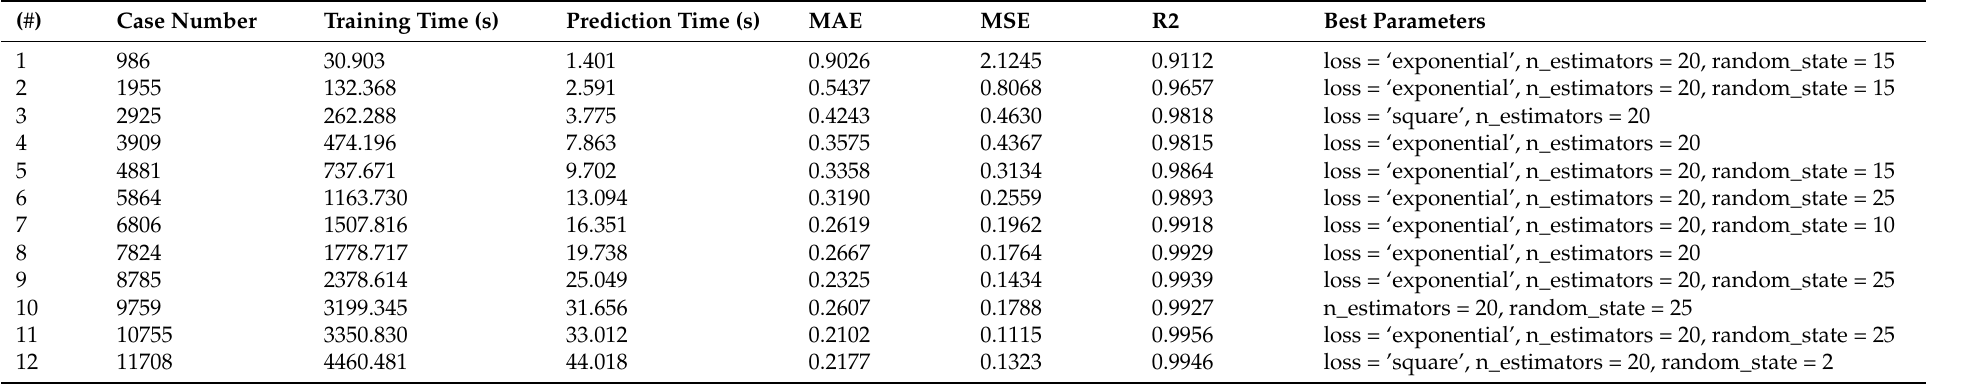
Table A6. Results of running the model with:AdaBoostRegressor +